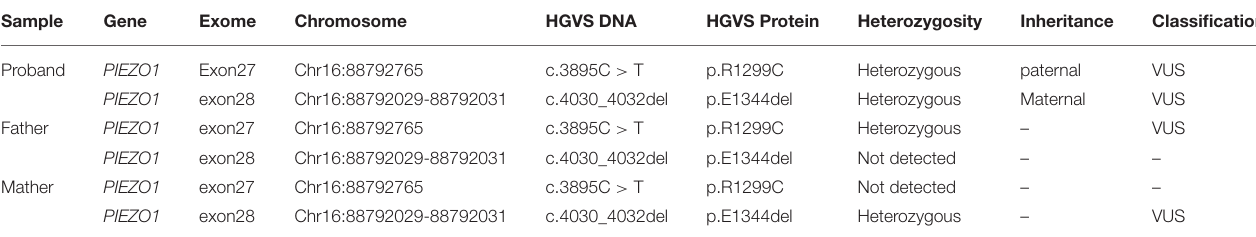
TABLE 1 | Diagnostic variants of the proband and parents.